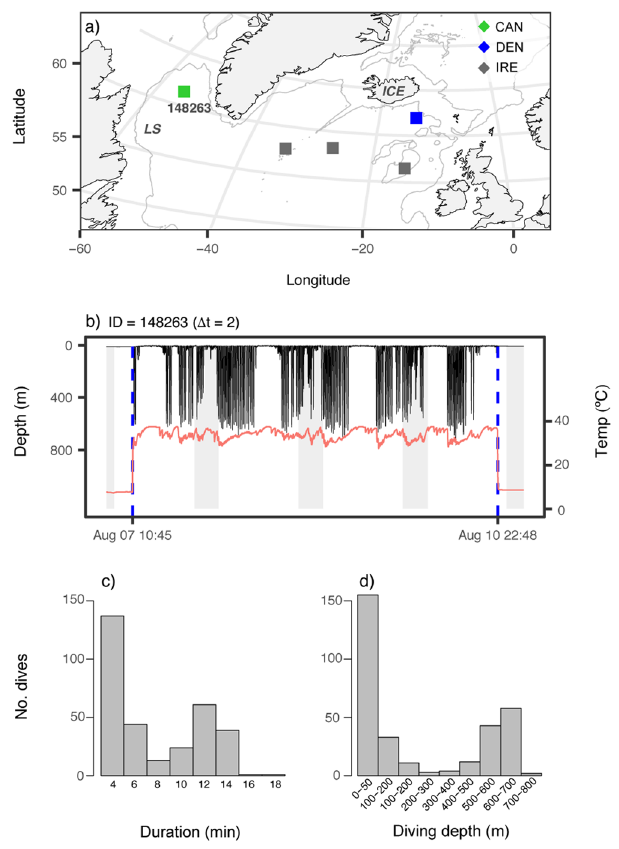
Figure 2. Predation by marine mammals. ( a ) Pop-up locations for the tags consumed by marine mammals, color-coded by origin. Grey lines indicate the 1000 m bathymetry contour. ICE = Iceland and LS = Labrador Sea. ( b ) Depth (black) and temperature (red) profiles for the retrieved tag consumed in the Labrador Sea, with blue vertical lines indicating the time of ingestion and expulsion and grey areas indicating night. Counts of the duration ( c ) and maximum depth ( d ) of dives (n = 320) recorded by the tag ingested in the Labrador Sea. Tag ID and temporal resolution of time series data ( Δ t) are stated above panel b, and the corresponding Tag ID is also indicated in panel